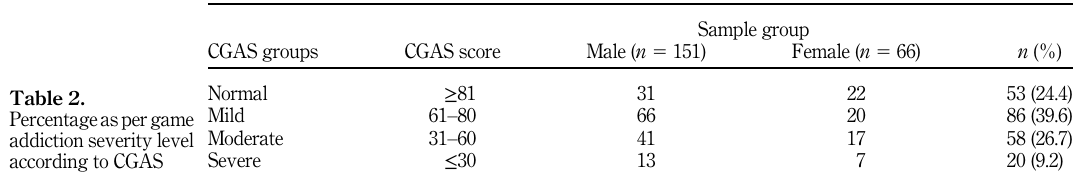
Table 1. Mean score, SD, maximum-minimum scores from CGAS and T-GDS